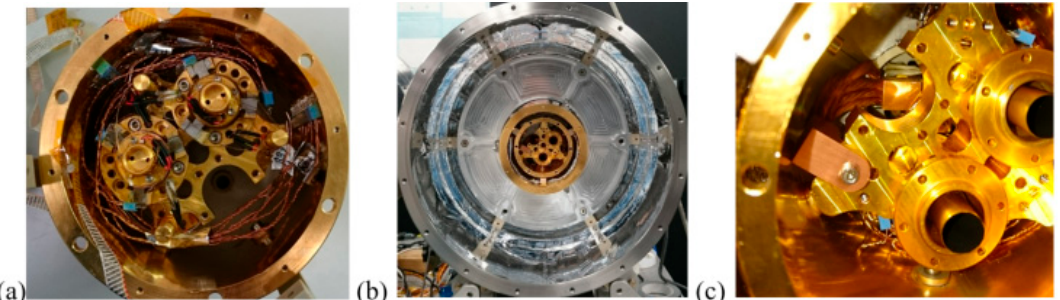
Figure 6. Photographs of the assembly of CSAR_V2 showing, from left to right, ( a ) two cavities mounted on the temperature reference block ( b ) the radiometer head coupled to the high-power Stirling cooler (HPSC) and mounted inside the cryostat and terrestrial vacuum can ( c ) close up of cavities showing thermal link to the HPSC.